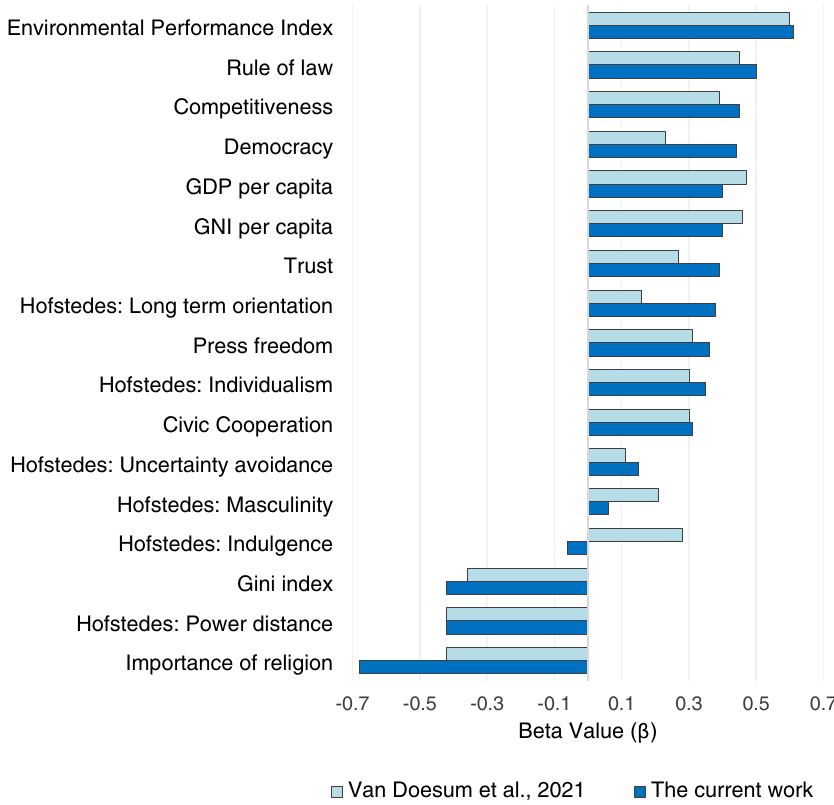
Figure 3. Comparison of Beta value (as an indicator of the effect size and direction of the effect) between the current work and Van Doesum and colleagues (2021). The Beta values can be interpreted in a similar way to Pearson coefficients. The findings for press freedom from the previous work 11 was reverse scored for the sake of this comparison due to differences in